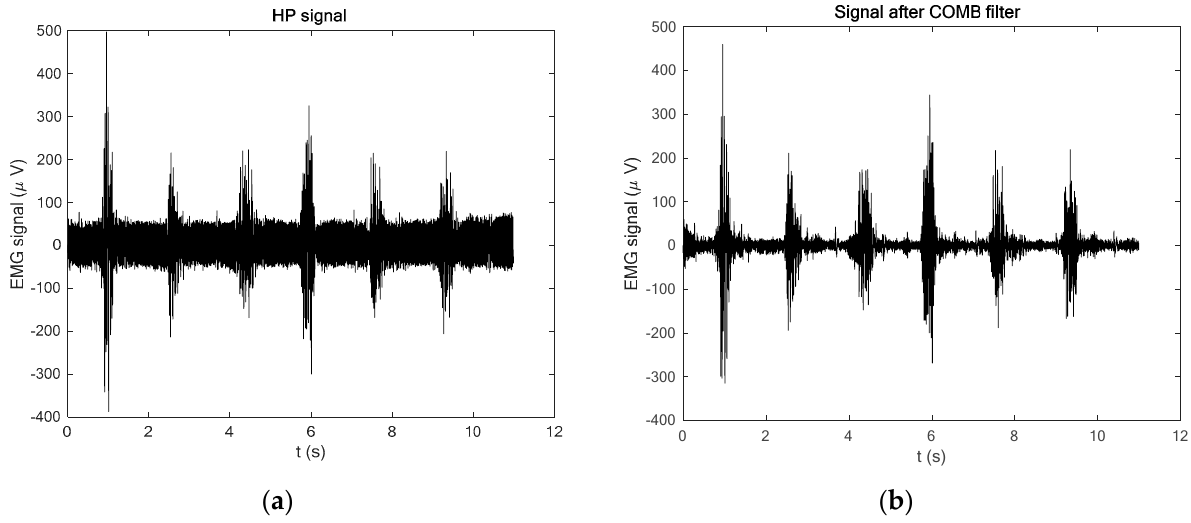
Figure 12. EMG signal with high impact of environmental disturbances for right abdominal muscle, ( a ) after low-frequency removal (3rd order Butterworth HP filter, f c = 10 Hz), ( b ) filtered by the comb filter ( M = 40 and Δ f = ± 0.5 Hz). Table 2. Coefficients of comb filters for different stopbands.